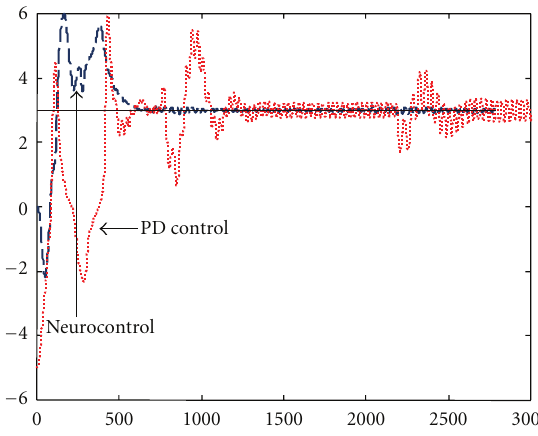
Figure 2: Tracking control of θ 1 (method